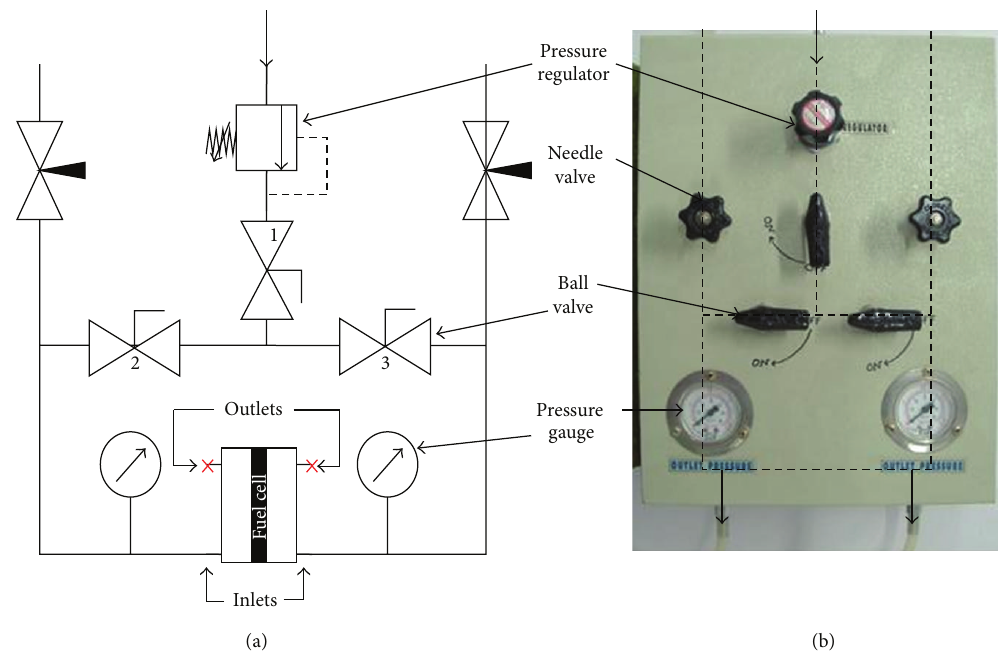
Figure 3: Experimental arrangement for leak and puncture test: (a) schematic diagram and (b) hardware.